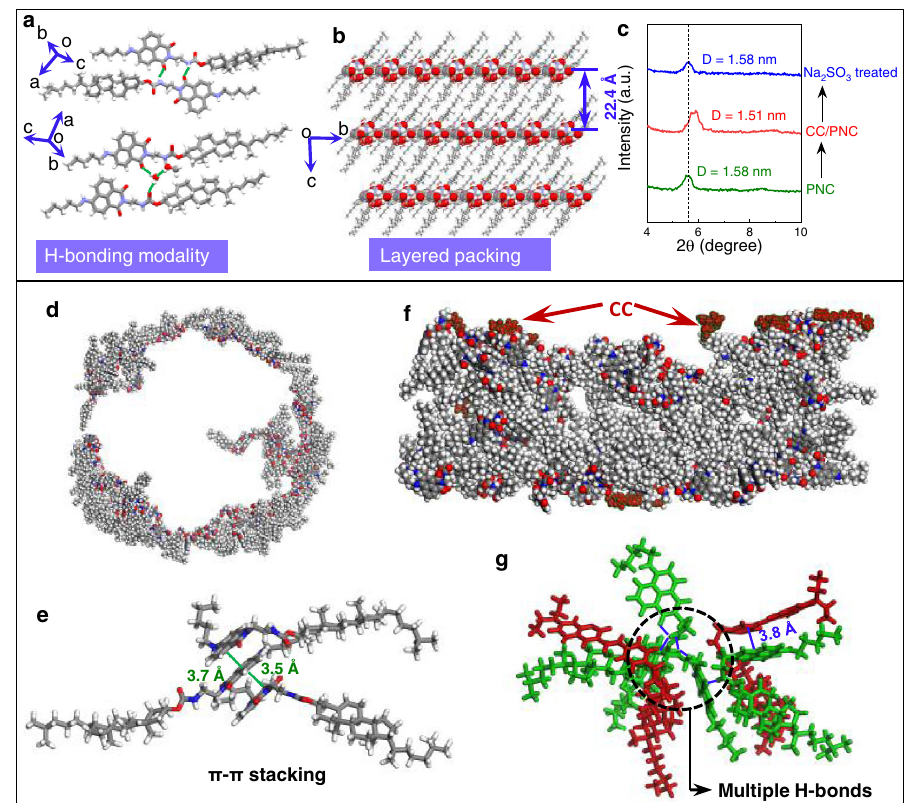
Fig. 7 Stacking model of assemblies. a , b Hydrogen bonding modality as well as packing of PNC in X-ray structures. If not speci fi cally noted, C, H, O, and N atoms are marked in gray, white, red, and blue respectively. c Small angel XRD pattern comparison of PNC, PNC/CC coassembly and Na 2 SO 3 treated PNC/ CC coassembly. d , e MD simulation results (50 ns) of PNC as well as the detailed π - π stacking interactions between naphthlimides. f The corresponding MD simulation results of PNC/CC coassembly. Dark red clusters represent coumarin moieties of CC. g Speci fi c packing mode of CC/PNC where green and red stand for PNC and CC respectively for clarity. Blue solid lines represent weak